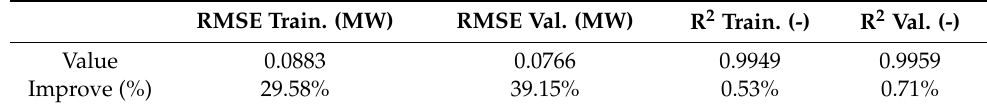
Table 5. Computed RMSE and R 2 index values for optimal RNN